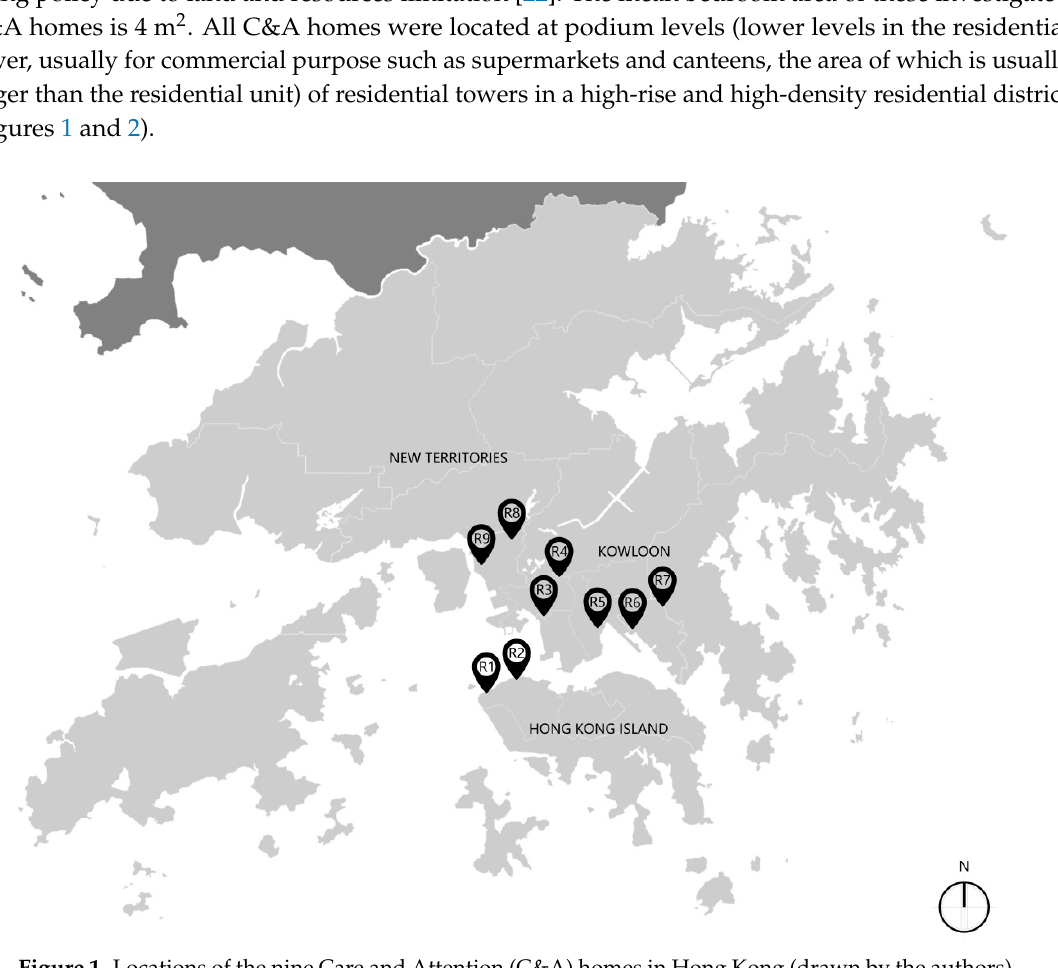
Figure 1. Locations of the nine Care and Attention (C&A) homes in Hong Kong (drawn by the authors).